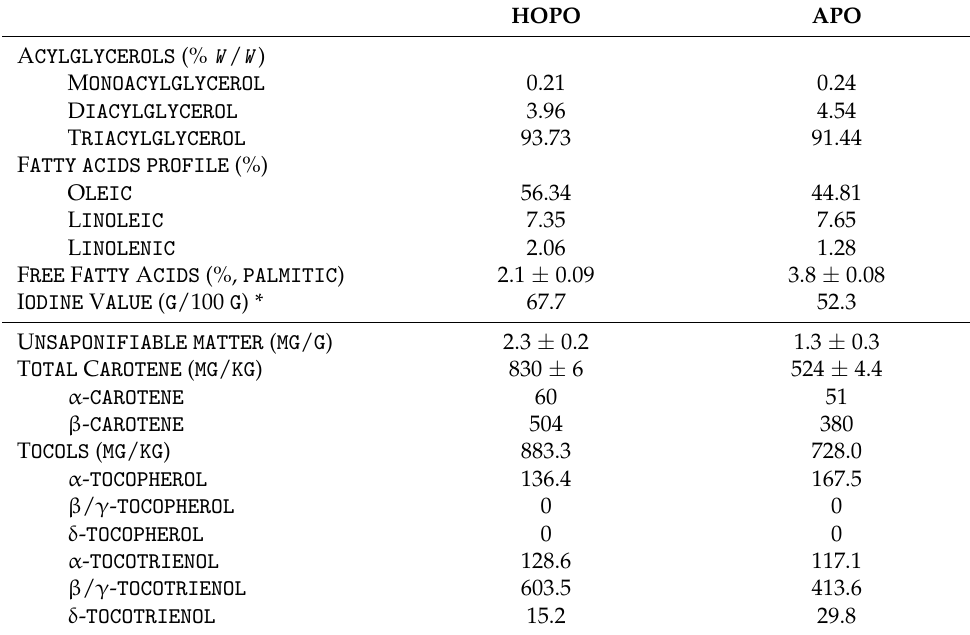
Table 1. Physicochemical characteristics of hybrid (HOPO— E. oleifera × E. guineensis ) and African (APO— E. guineensis ) palm